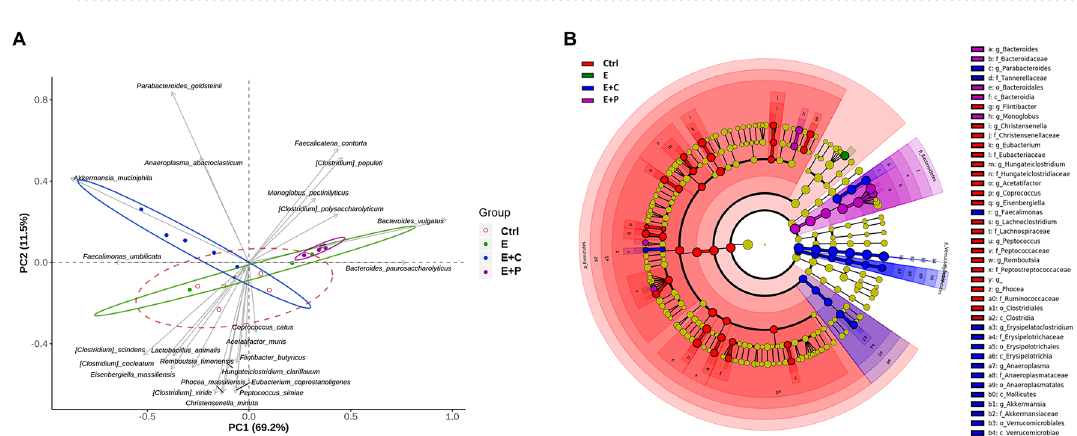
Figure 2. High-fiber diet alters the composition of the gut microbial community. ( A ) Principal coordinate analysis (PCoA) biplot of the fecal microbiota composition. ( B ) The cladogram of the linear discriminant analysis effect size (LEfSe) analysis for differentially abundant taxa of fecal microbiotas in the four groups; Ctrl (red), control group; E (green), emphysema group; E + C (blue), emphysema with high-cellulose diet group; E + P (violet), emphysema with high-pectin diet group. (n = 5 mice per